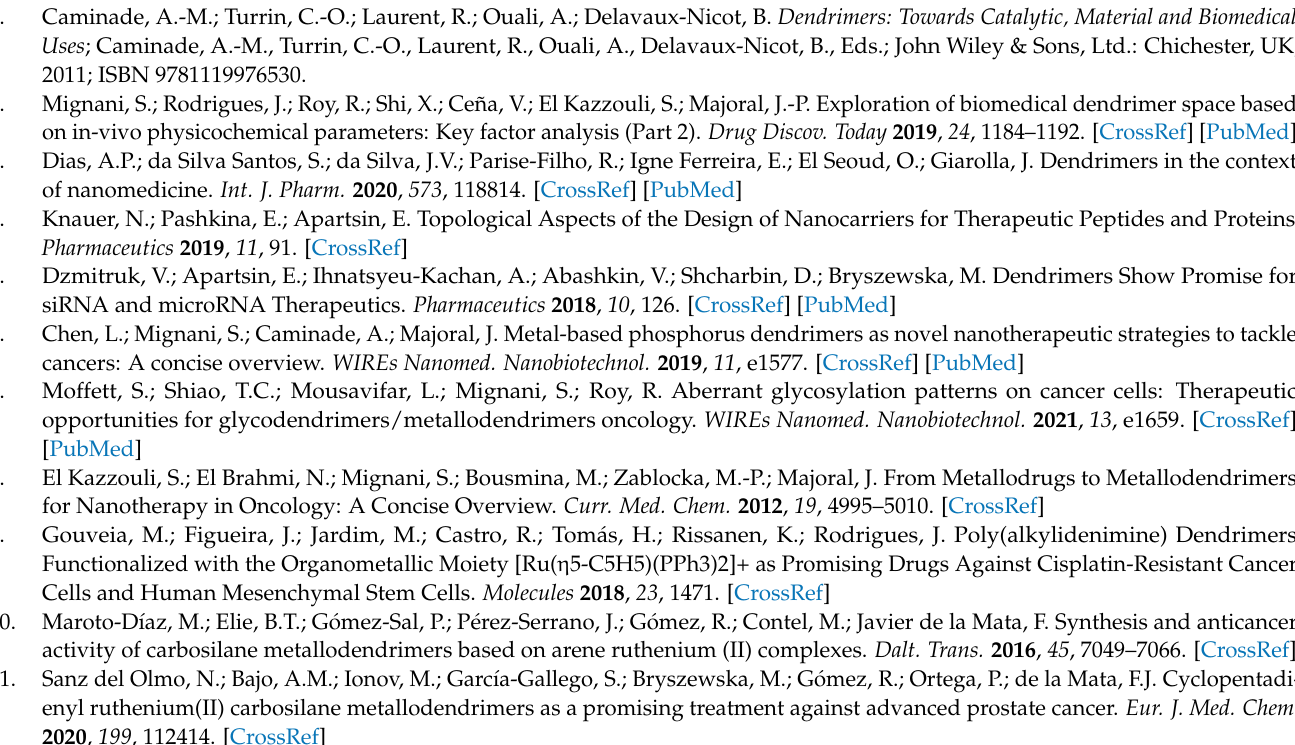
gregates. Figure S2: DLS profiles of CuD and AuD metallodendrons stored for >9 months. Figure S3: Zeta potential profiles of 50 µ M water solutions of CuD and AuD